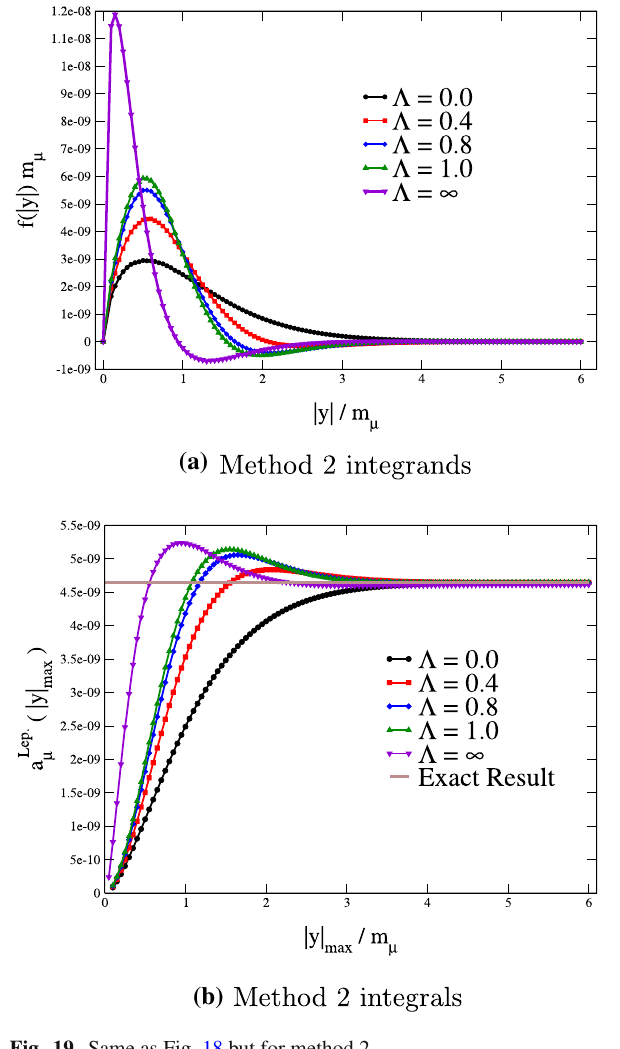
Fig. 19 Same as Fig. 18 but for method